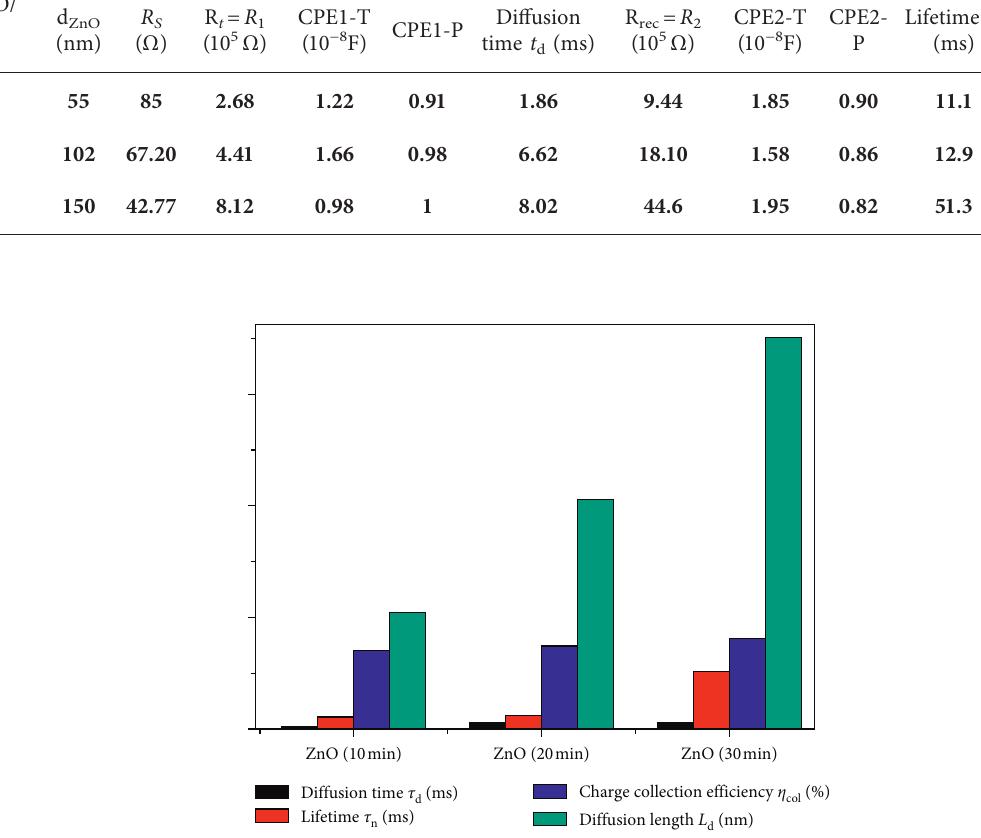
Figure 8: Evolution of parameters for the ITO/ZnO/CdS/CuO:Co/Ag heterojunction at different thicknesses of zinc